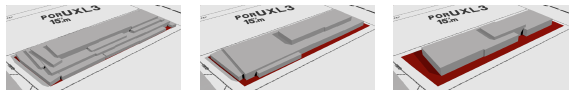
Figure 6. Different simulation with different level of generaliza- tion.